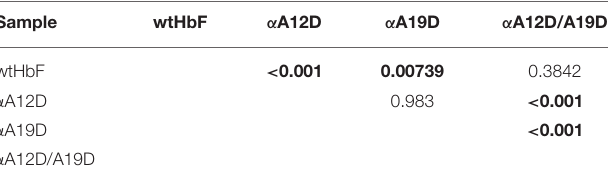
TABLE 3 | Correlation map— p -value at the 0.01 significance level.